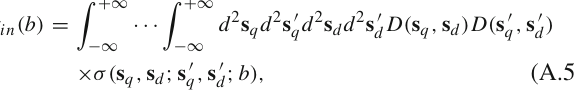
The inelastic scattering probability in the BB model